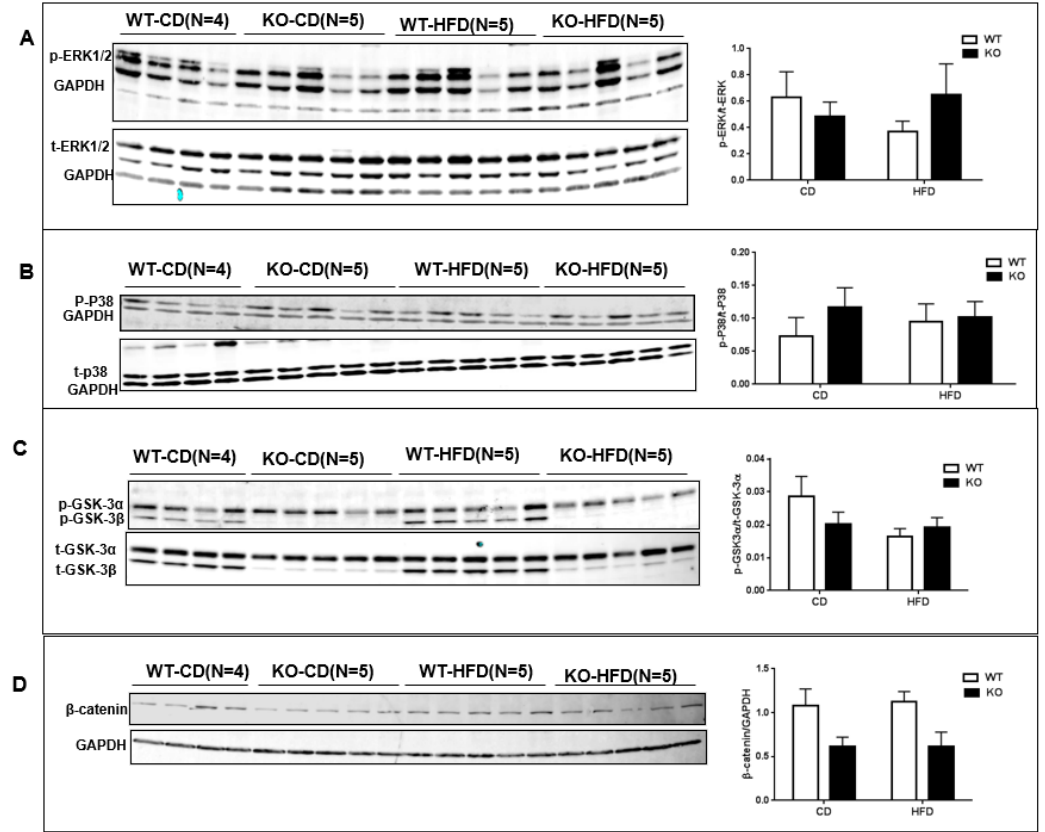
Figure 5. Analysis of signaling pathways in WT and CM-GSK-3 β –Kos. LV lysates from WT and CM-GSK-3 β KO animals were analyzed by immunoblotting with the following antibodies: ( A ) ERK phosphorylated at Thr202 / Tyr204, ( B ) p38 phosphorylated at Thr180 / Tyr182, ( C ) total and phospho-GSK-3 α / β , ( D ) β -catenin expression in WT and KO hearts fed CD or HFD for 55